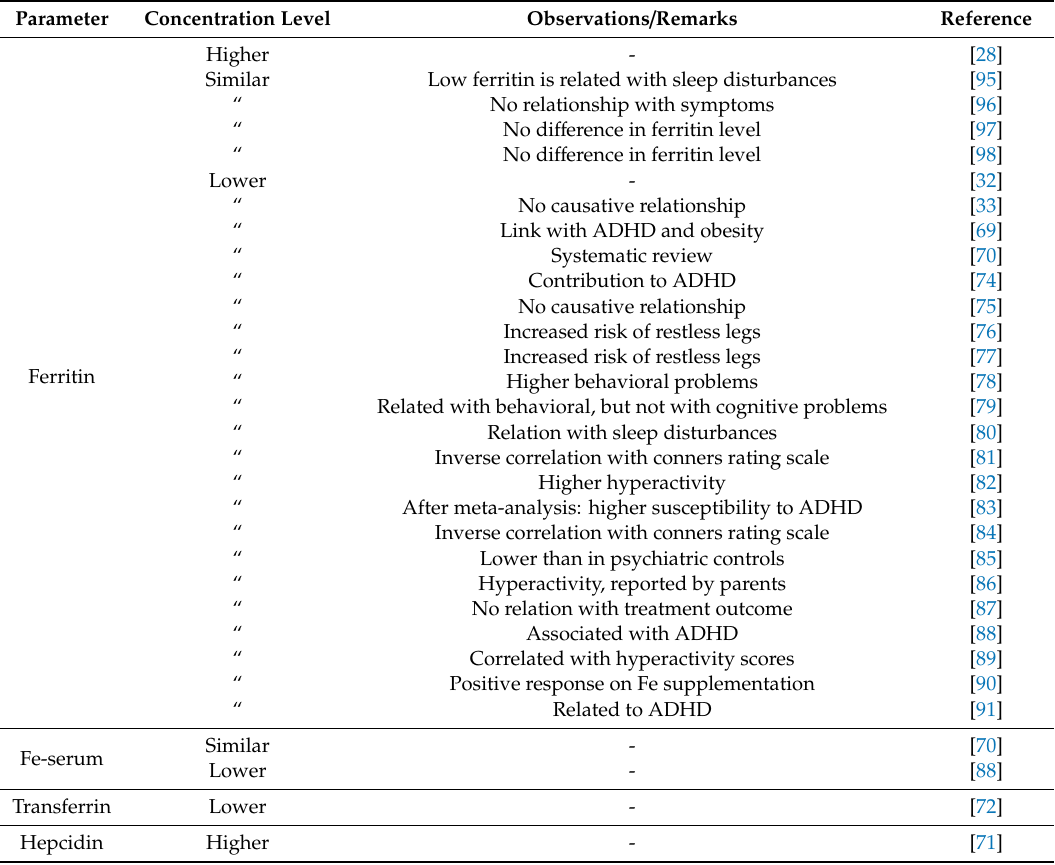
Table 1. Peripheral parameters of Fe status in attention-deficit / hyperactivity disorder (ADHD) patients compared to controls and relation with ADHD symptoms (“: the same as above; “-”: no additional